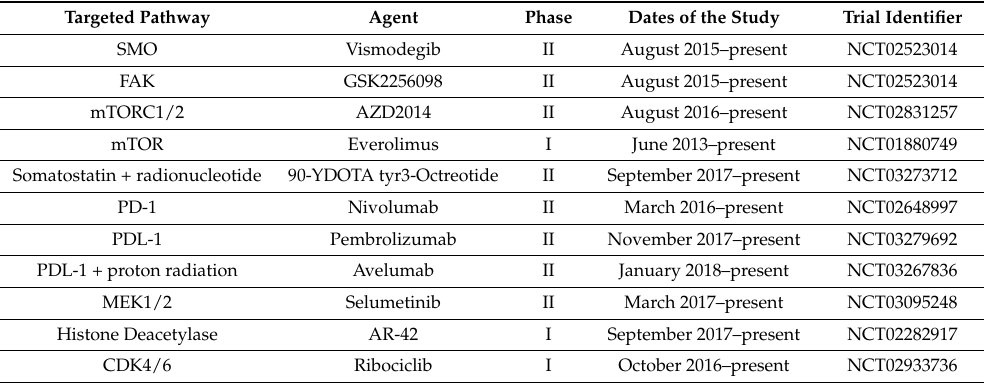
Table 2. Current ongoing clinical trials for patients with primary and recurrent